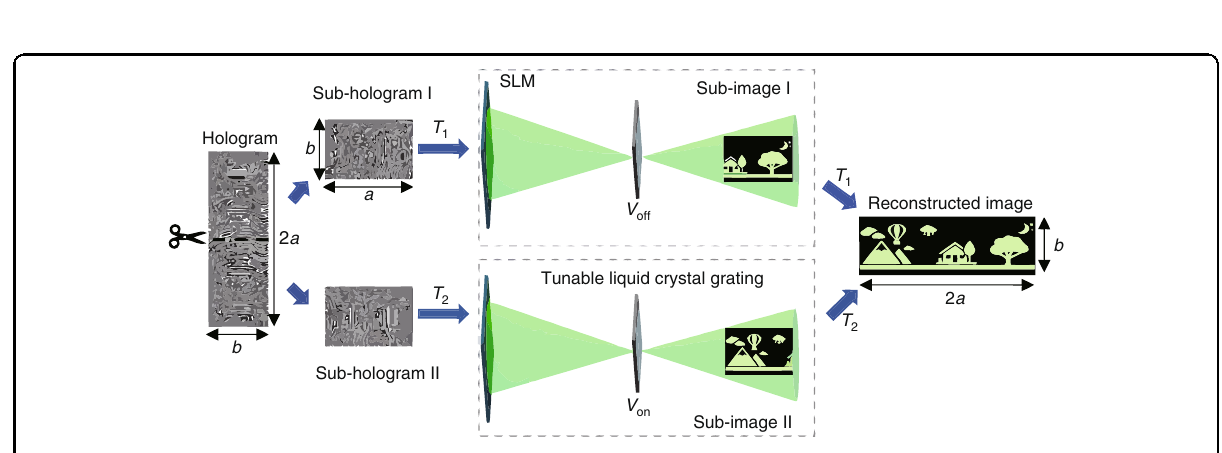
Fig. 5 Principle of the large size holographic 3D